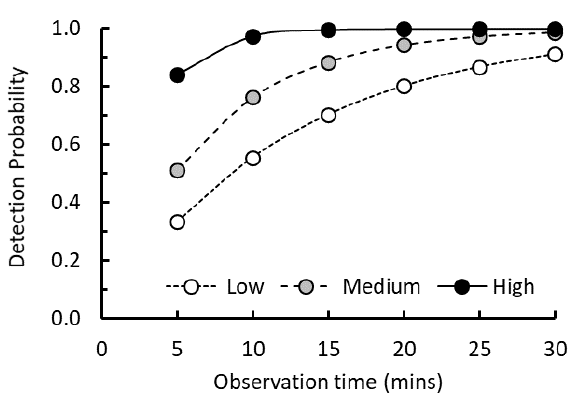
Figure 1. Probability of observing at least one pollinating insect in 2 x 2 m patches of low, medium, or high floral density as a function of observation time. Probability was calculated by binomial expansion using the mean probability of pollinators being observed in any one 5- minute observation period (see Methods for